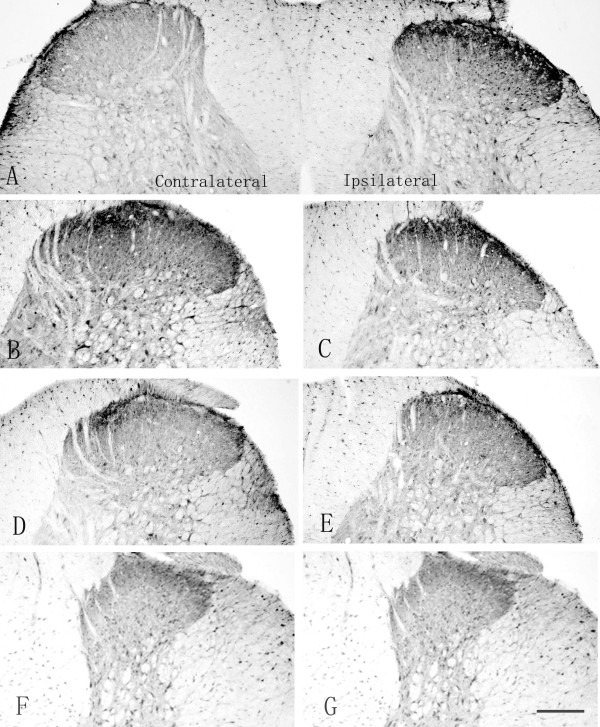
Segmental upregulation of spinal BDNF after hind-paw incision. Representative photomicrographs of BDNF-IR density in the lumbar (L4–L5) (Figure 1A-E) and thoracic segments (T1–T2) (Figure 1F and G) of the spinal cord in the rats after hind-paw incision. In the lumbar segments, the increased BDNF expression in the dorsal horns of the ipsilateral spinal cord was observed at 1 hour (Figure 1A), 6 hours (Figure 1B) and 1 day (Figure 1C) after incision. At 3 days after incision, BDNF expression (Figure 1D) was comparable to the sham-operated control (Figure 1E). No significant difference of BDNF expression in thoracic segments between the control (Figure 1F) and 6 hour after incision (Figure 1G). Bar = 150 μm.